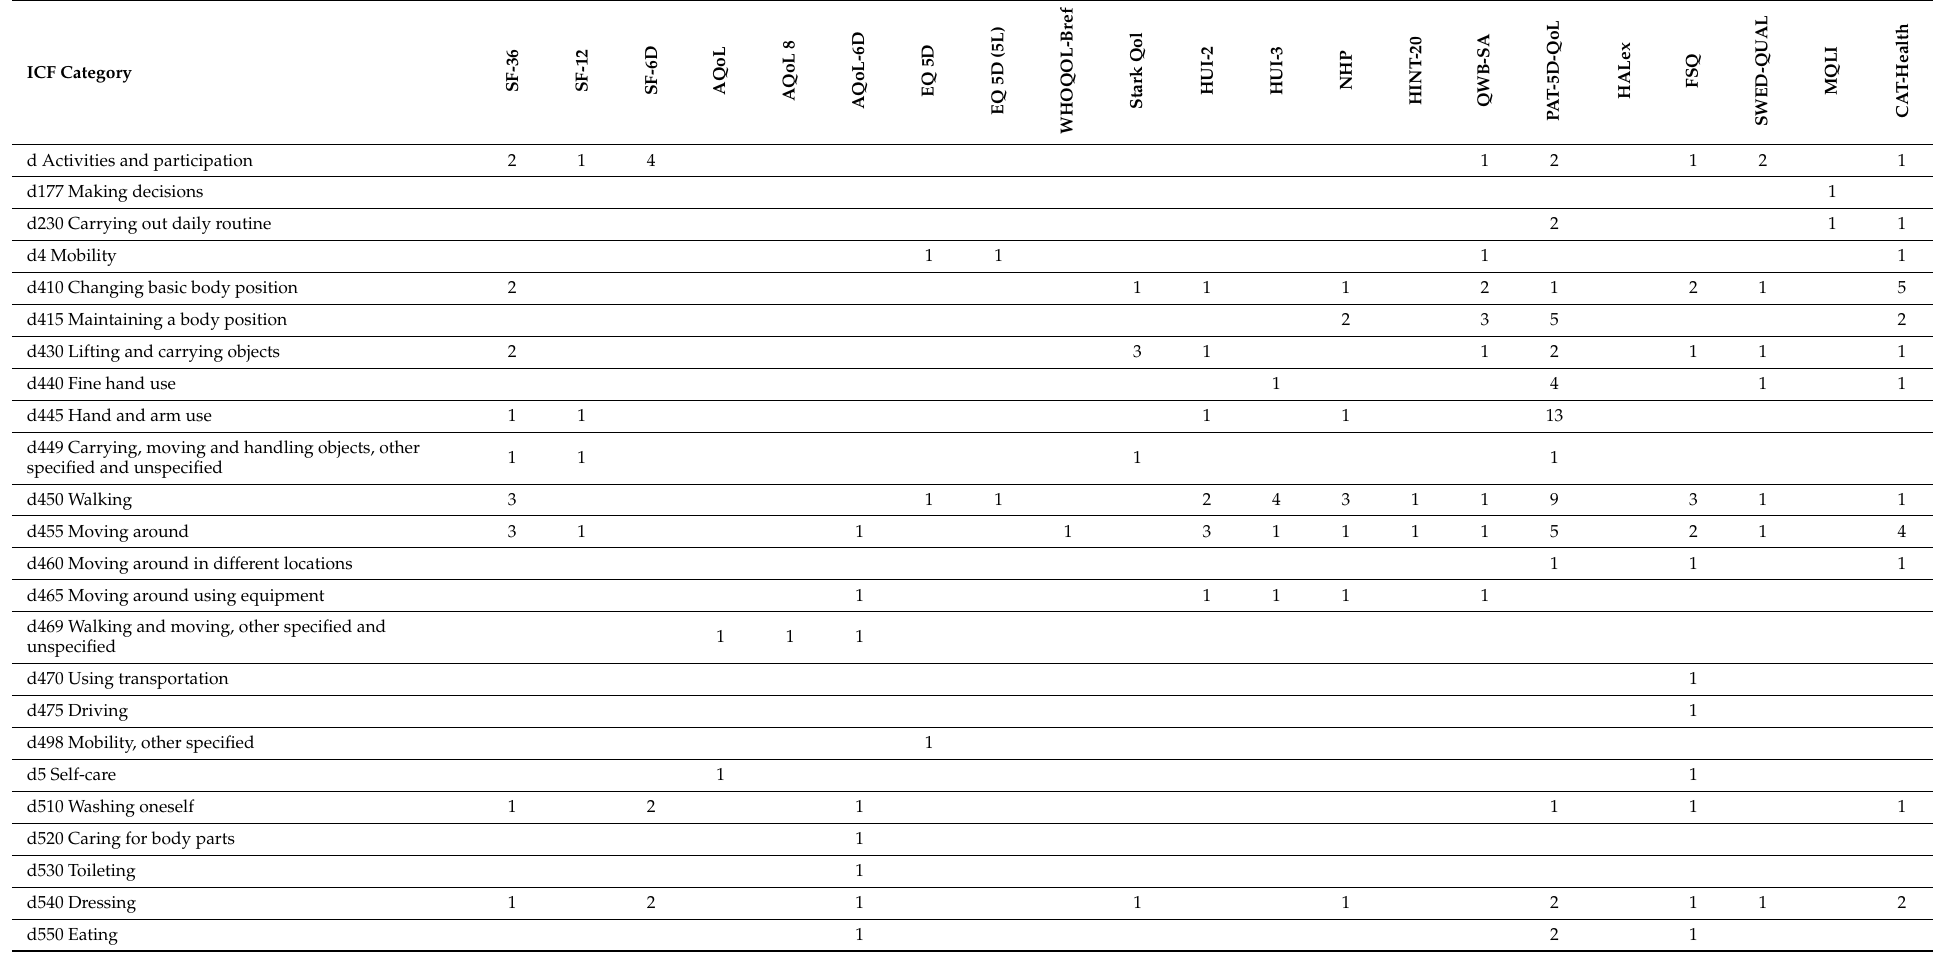
Table 6. Activities and participation categories two level ICF linking of HRQOL